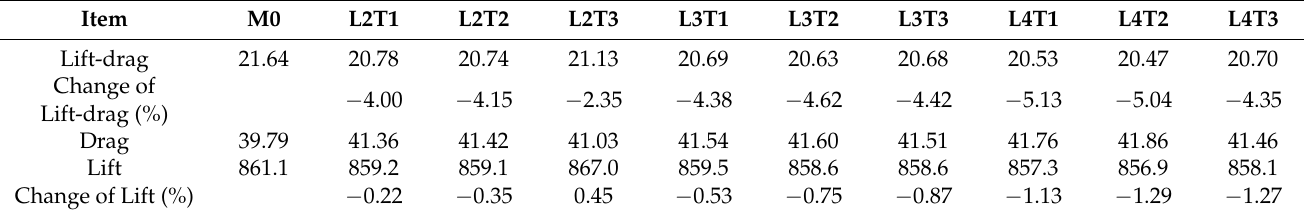
Table 4. Energy performance for different